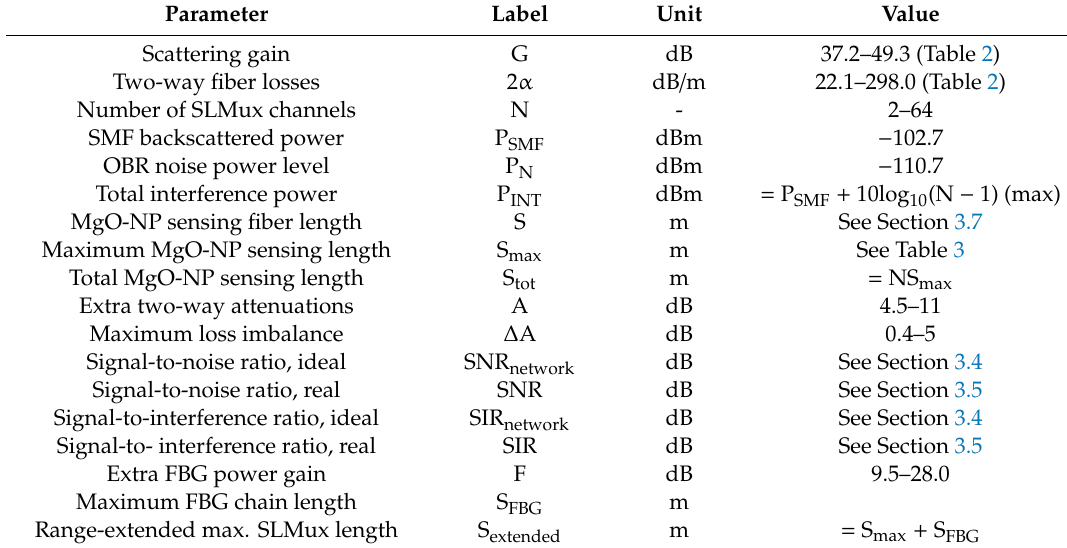
Table 1. List of the main parameters used in the performance analysis of SLMux.